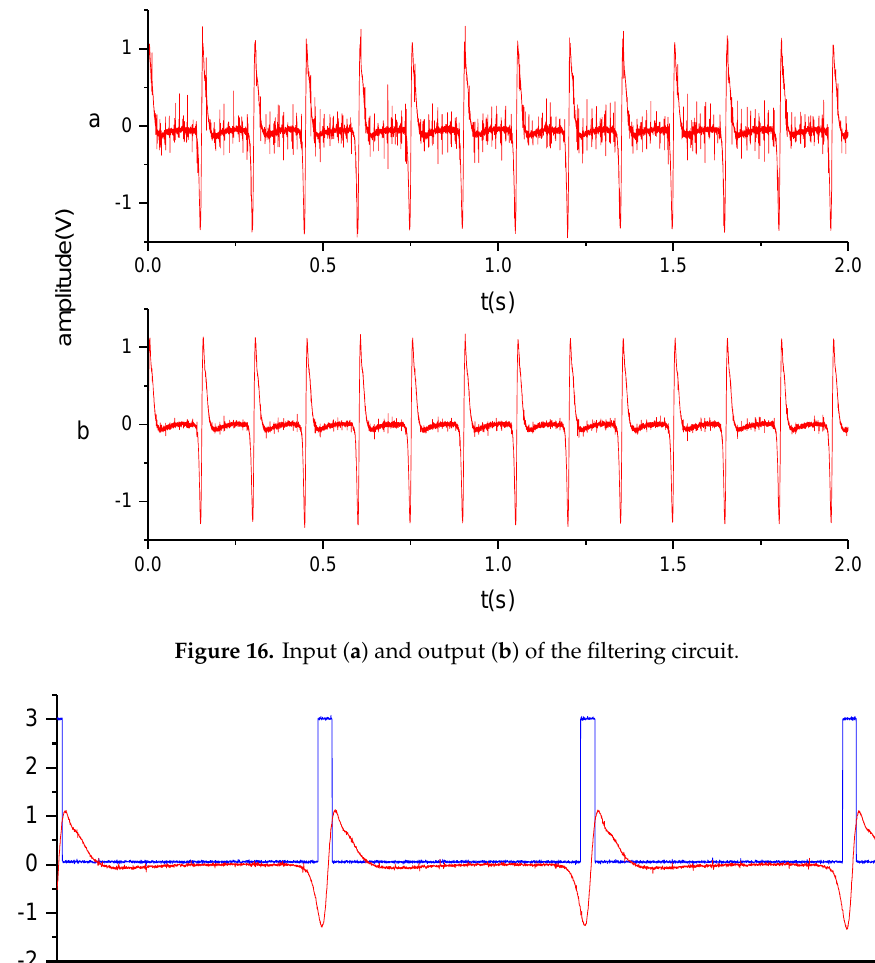
Figure 17. Analog input and digital output of the comparator circuit.